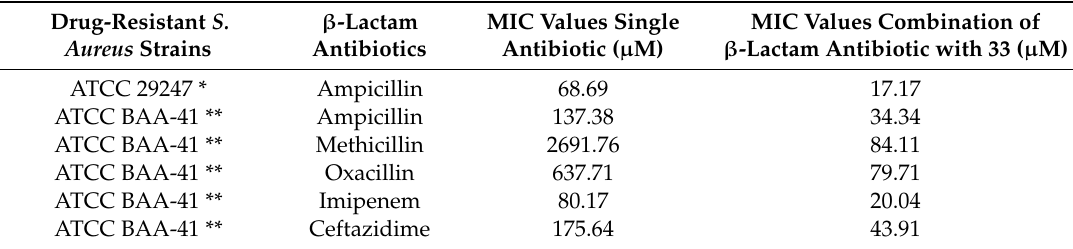
Table 4. MIC values of β -lactam antibiotics in combination with quinolinium 33 . Drug-Resistant